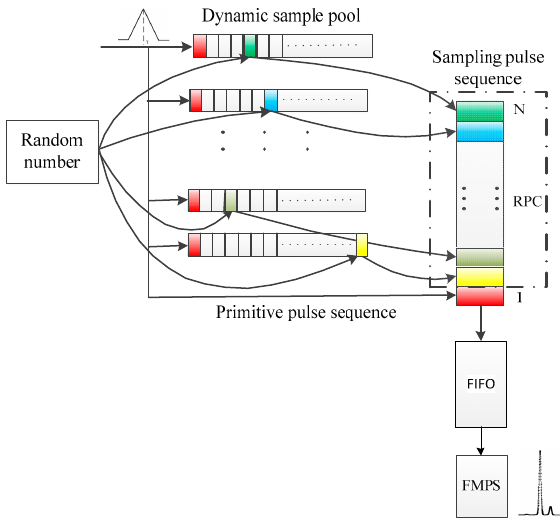
Figure 3. Working principle of the RPC.